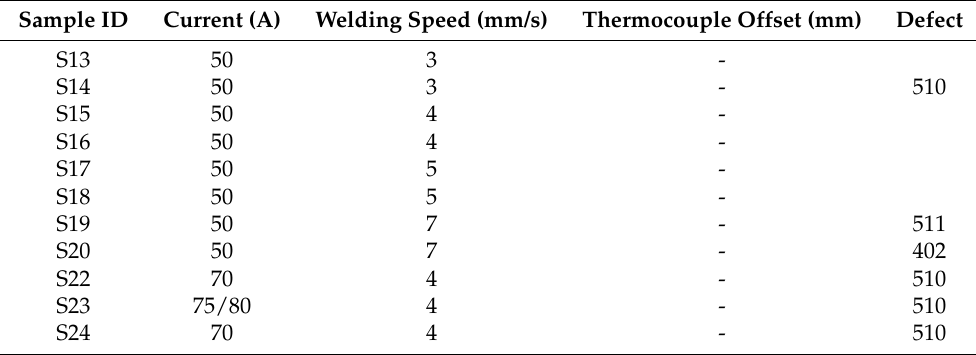
Table 3. Parameters of welding processes selected for making the sample joints (511 indicates incomplete fill; 510 indicates burn-through; and 402 indicates a lack of penetration/incomplete